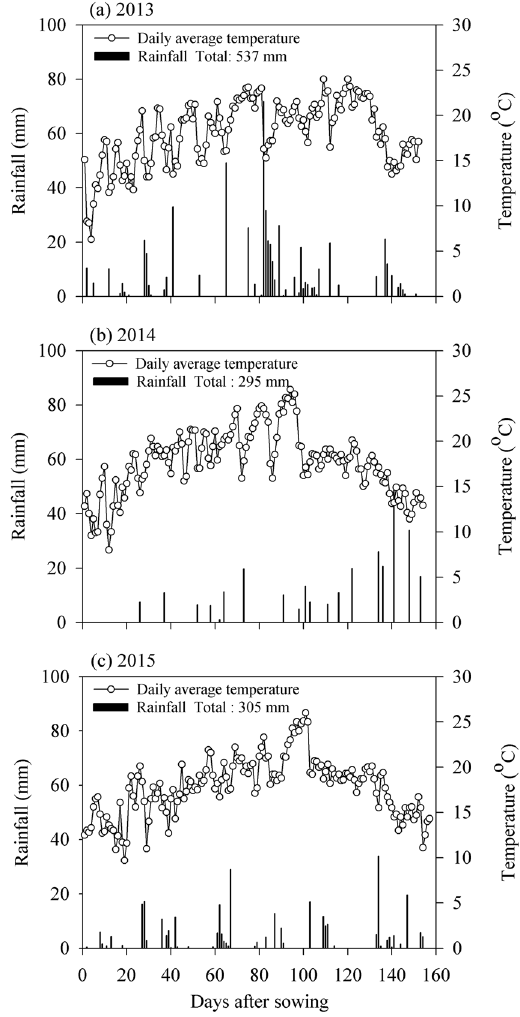
Figure 5. Daily average temperatures and rainfall during the foxtail millet growing seasons in the experimental fields at Pengyang Experimental Station, Ningxia Province, China in